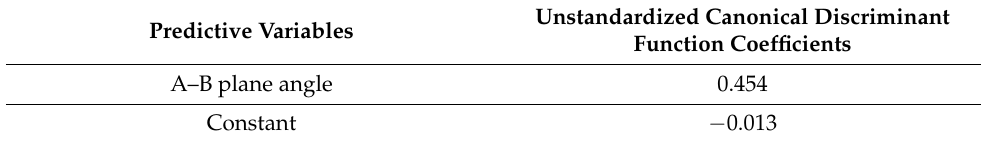
Table 5. Stepwise discriminant